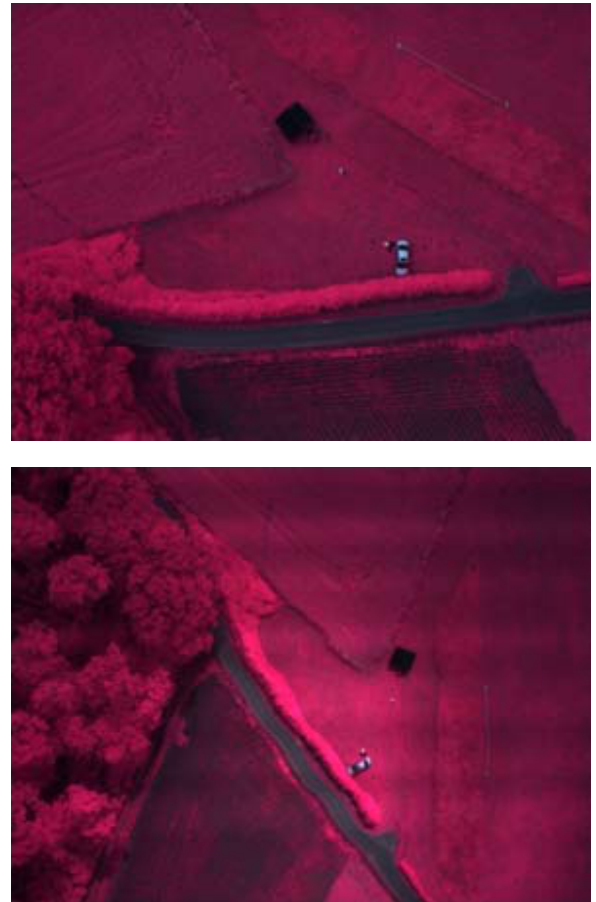
Figure 2. ADC images with no (top) and with rolling shutter effect (down)